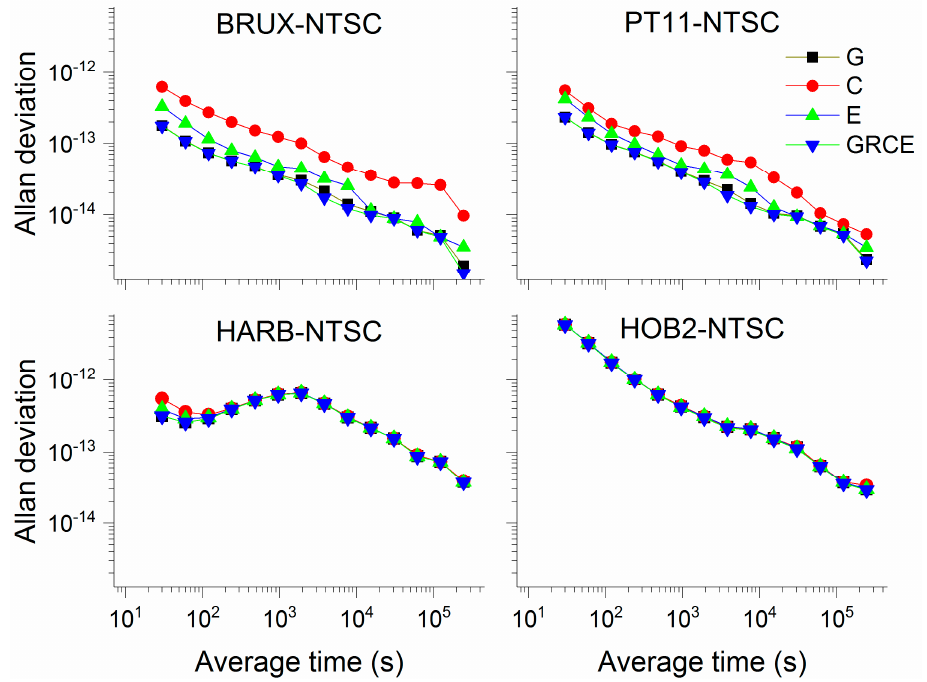
Figure 8. Allan deviation of four time links using COD products with four models.